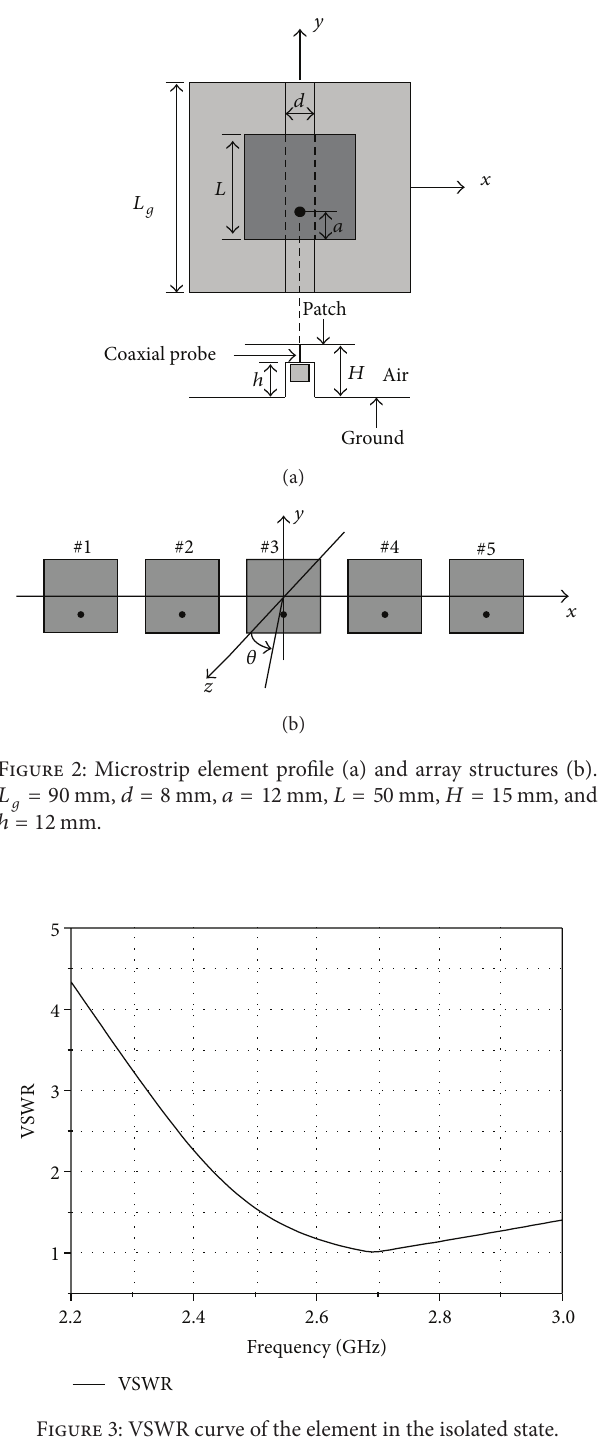
electric fields of the elements and the array. In the following simulations of DOA estimations, all incident signals are uncorrelated and impinge upon the array from 𝑥𝑜𝑧 plane.